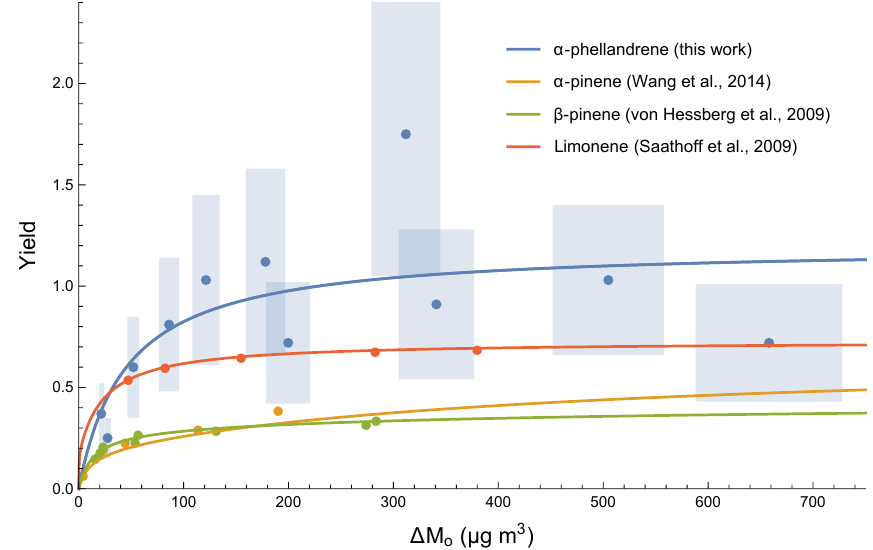
Figure 12. Comparison of SOA yield data for α -phellandrene with other monoterpene ozonolysis experiments. Lines are the best empirical model fits (Odum et al.,